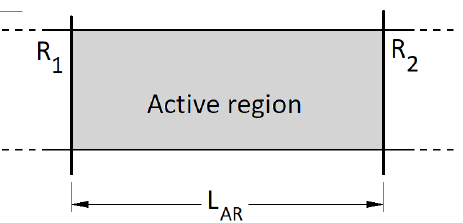
Figure 3. Typical sensor pair containing two partially reflecting mirrors R 1 and R 2 . L AR is the length of the active region or FBGP